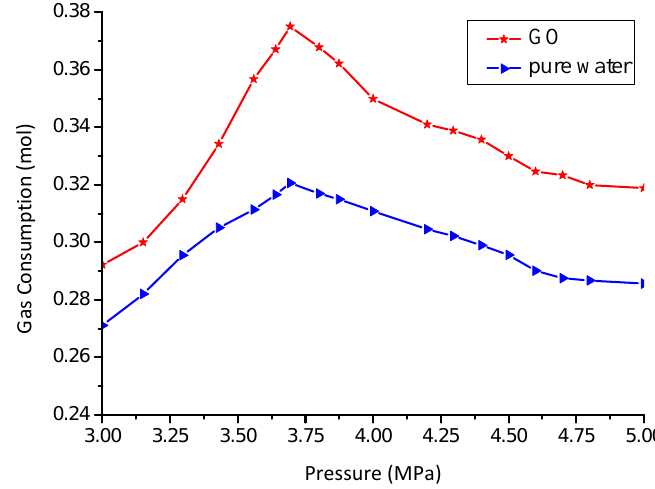
Figure 6. Gas consumption in the GO or pure water system at 279 K and different pressures.